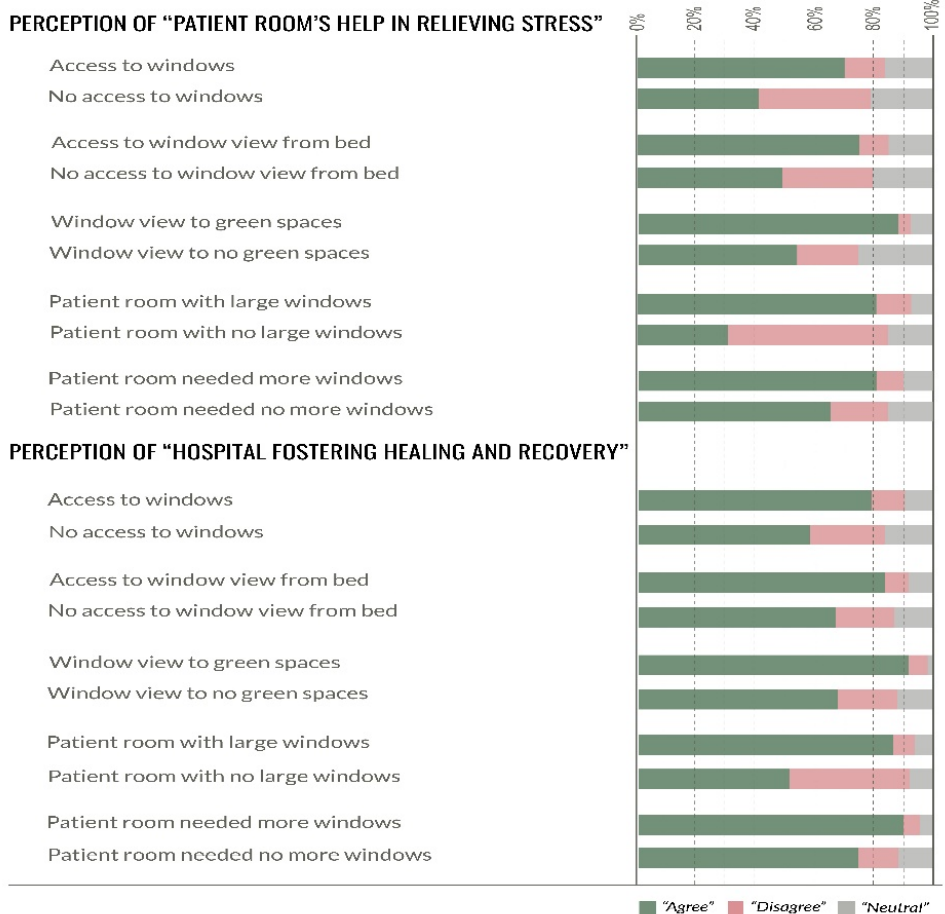
Figure 2. Chi-square test comparisons for “patient room relieving stress” and “hospital fostering healing” across participants with windows/no windows, view from bed/no views, access to green views/no green views, window size, and need for more windows.